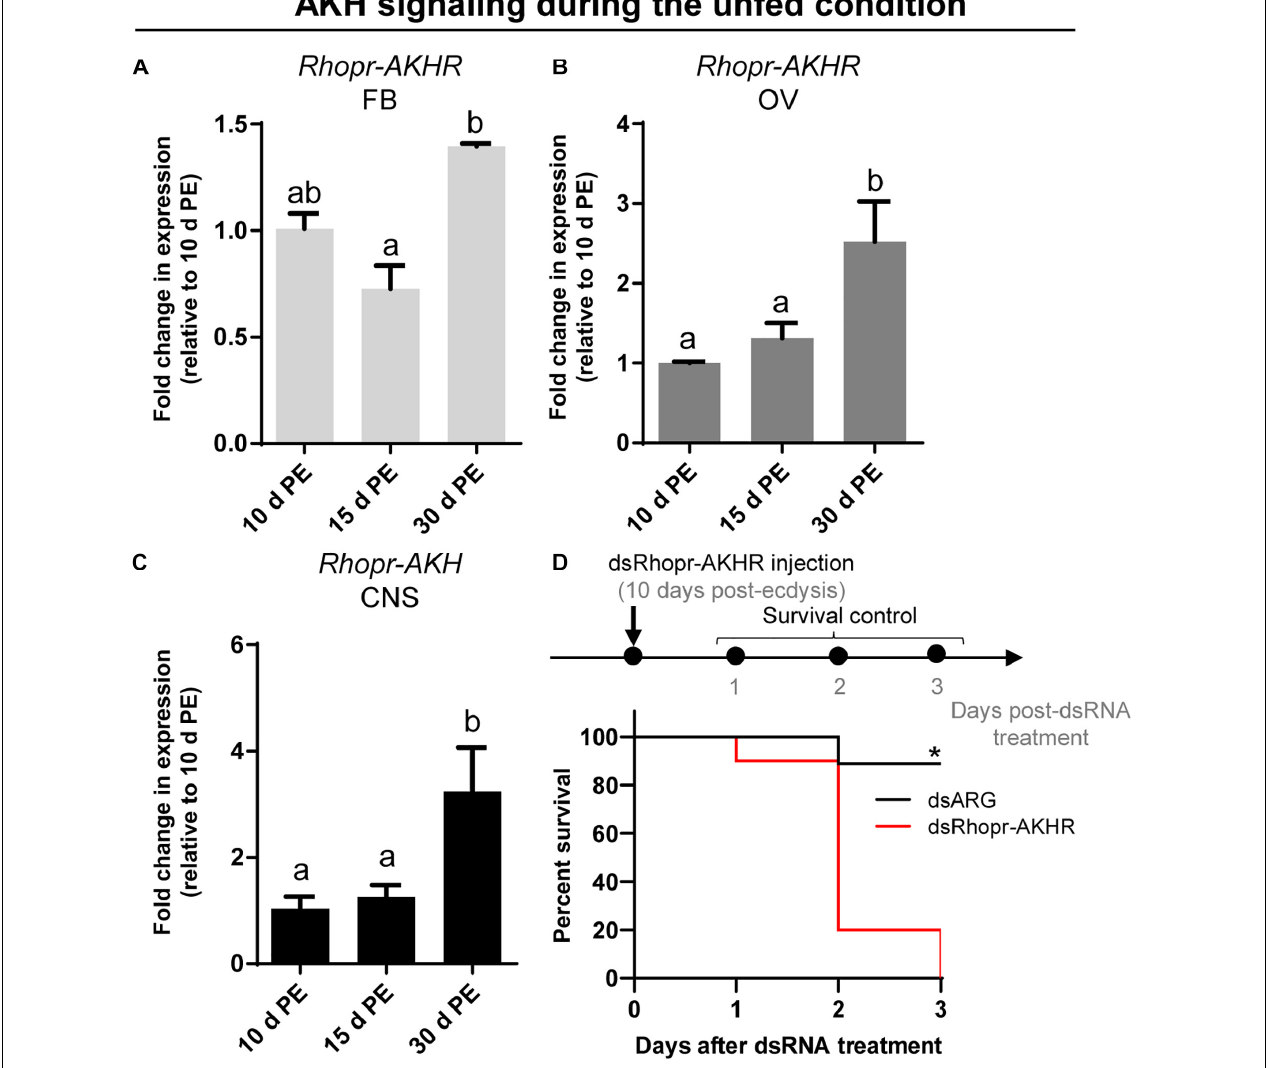
FIGURE 7 | Transcript expression of Rhopr-AKHR and Rhopr-AKH in fat body, ovaries and CNS following ecdysis into adults. Rhopr-AKHR transcript expression in the fat body (A) and ovaries (B) , and Rhopr-AKH transcript expression in the CNS (C) were assessed at various times post-ecdysis (PE) in adult females. The effects were measured by RT-qPCR. The y -axis represents the fold change in expression relative to 10 days PE (value ∼ 1). The results are shown as the mean ± SEM ( n = 3–4, where each n represents a pool of tissues from 3 insects). The statistically significant differences were determined by a one-way ANOVA and a Tukey’s test as the post hoc test. Significance of P < 0.05 is denoted using letters to indicate bars that are significantly different from others. (D) Percent survival of dsRhopr-AKHR injected insects with respect to control (dsARG) over 3 days in the unfed condition ( n = 15). Differences in the survival curve were analyzed using the Log-Rank test (* p <